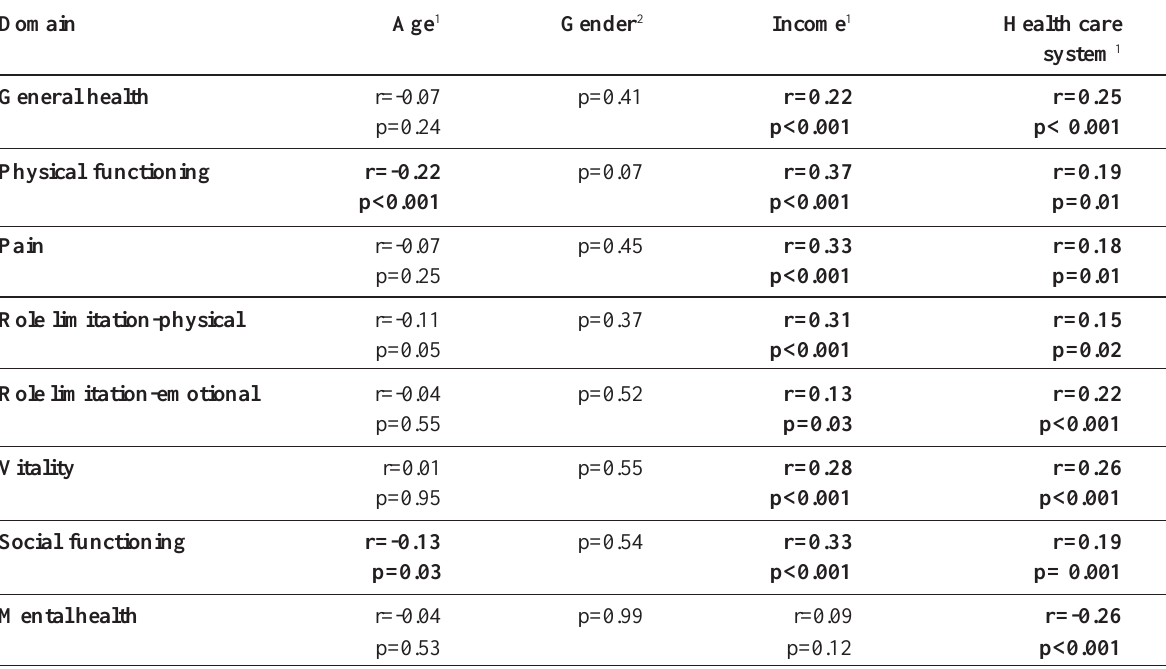
Table 2. Factors associated with the pre-exacerbation QOL of COPD patients